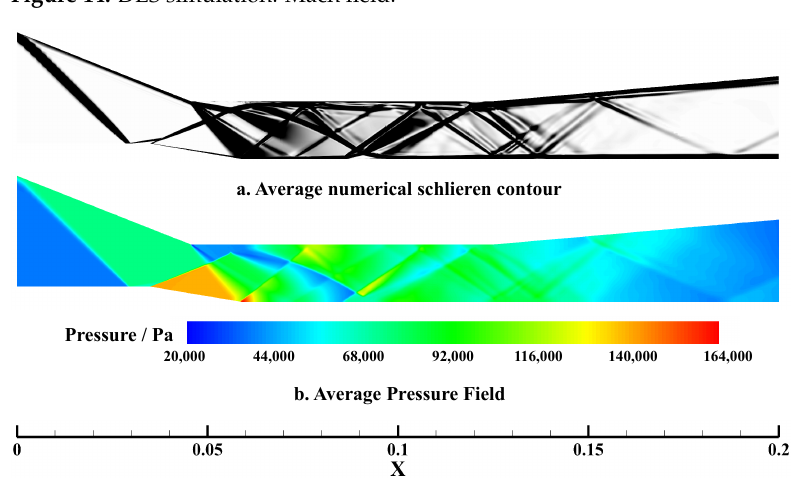
Figure 14. DES simulation: Mach field.